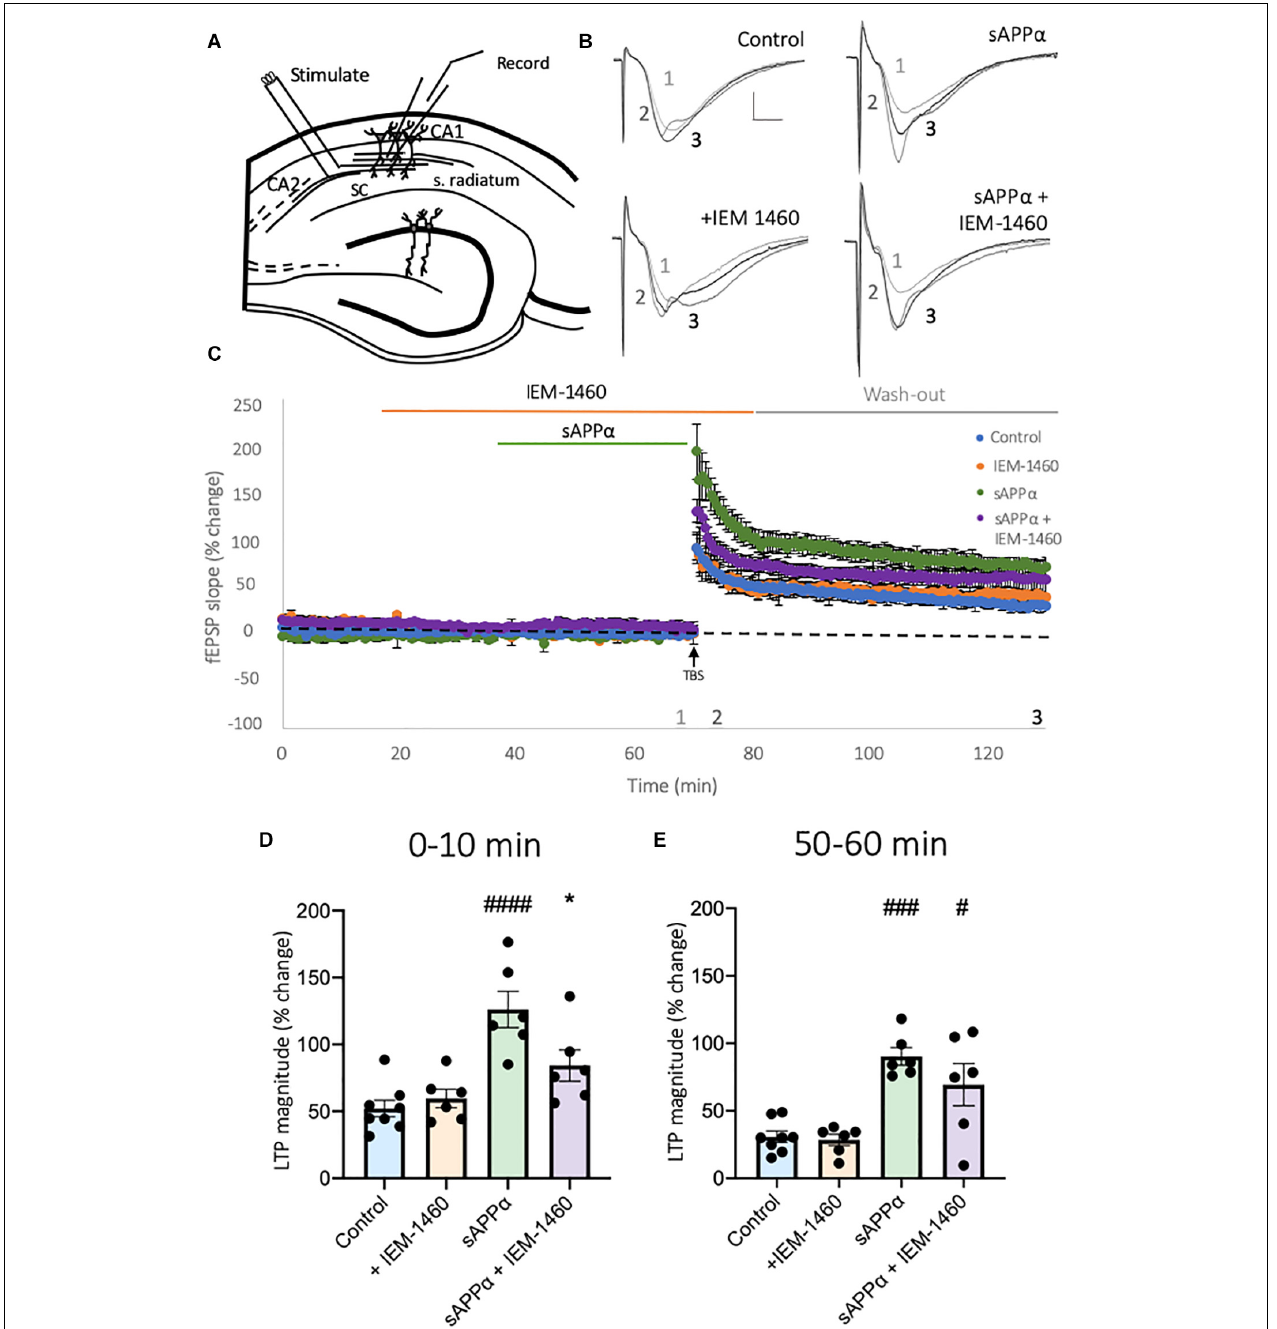
FIGURE 9 | Secreted amyloid precursor protein-alpha-enhanced LTP induction is dependent on activation of CP-AMPARs. (A) Representative schematic of transverse hippocampal slices showing the positioning of stimulation and recording electrodes in area CA1. (B) Representative fEPSP traces taken at the end of baseline recording (1), upon TBS (2), and 60 min post-TBS (3). Scale bar = 1 mV, 5 ms. (C) Average traces of control slices, receiving only a mild TBS (5 bursts at 5 Hz, 5 pulses per 100 Hz/burst; (cid:108) , n = 8 slices), IEM-1460 (100 µ M; (cid:108) , n = 6 slices), sAPP α (1 nM; (cid:108) , n = 6 slices) and sAPP α + IEM-1460-treated ( (cid:108) , n = 6 slices) conditions. All conditions are normalized to the average of baseline 10 min before TBS, and all data are presented as mean% change ± SD. Data shows summary histograms for (D) early and (E) late potentiation following TBS. To account for the minor effect of IEM-1460 on baseline synaptic transmission, data examining early potentiation in the presence of IEM-1460 are averaged from the first (D) 10 min post-TBS for each experimental group relative to baseline, averaged 10 min before TBS. Following washout late potentiation was measure from the final (E) 10 min post-TBS relative to baseline, averaged 10 min before application of IEM-1460. * p = 0.0334, # p = 0.0149, ### p = 0.0002, #### p ≤ 0.0001. Normality was detected by Shapiro-Wilk normality test. Significance was assessed by one-way ANOVA followed by Tukey’s multiple comparisons tests. Hashes (#) indicate significance between control and sAPP α -treated; asterisks (*) indicate significance